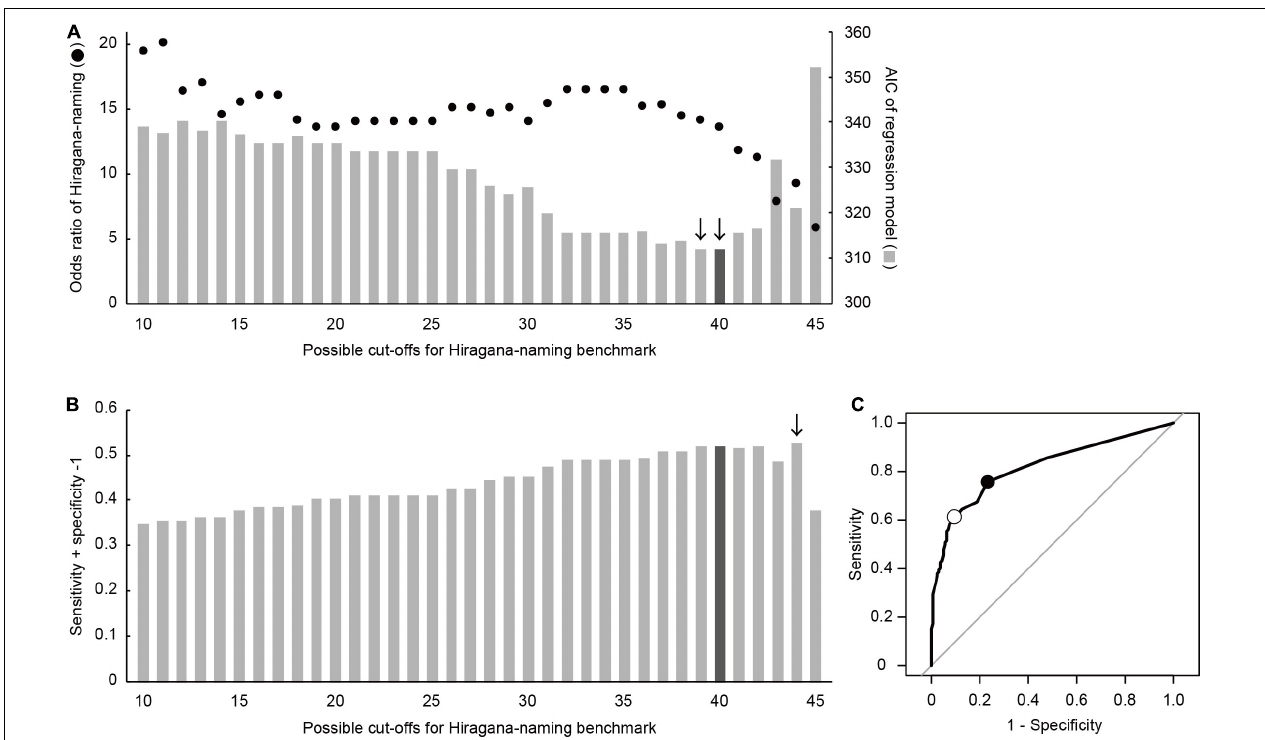
FIGURE 2 | (A) Changes in the results of binomial logistic regression analysis with respect to Hiragana-naming cut-offs from 10 to 45. Black dots indicate adjusted odds ratio of Hiragana naming and gray bars indicate AIC of the regression model at a given cut-off. (B) Changes in the distance between the diagonal reference line and ROC curve over possible Hiragana-naming cut-offs. For both panels (A,B) , arrows indicate recommended cut-off(s) based on each analysis, while a black bar at 40 letters indicates a selected optimal benchmark. (C) ROC curve with thresholds indicated at 40 (white circle) and 44 (black circle)